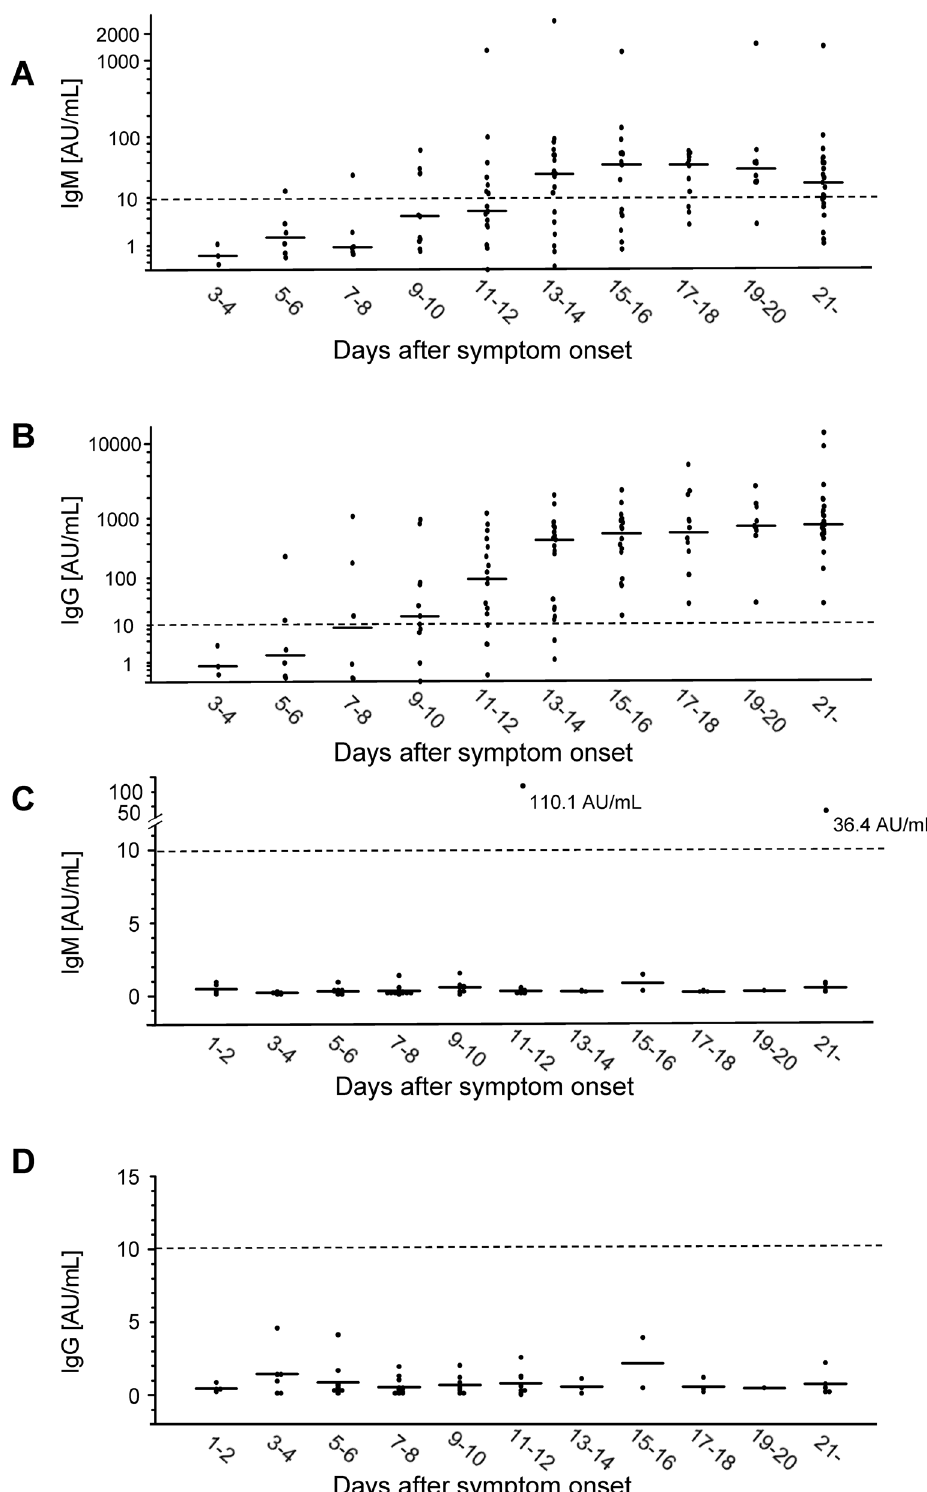
Figure 1. The time courses of serum titers of SARS-CoV-2 antibodies in COVID-19 patients after symptom onset. We measured the titers of SARS-CoV-2 IgM and SARS-CoV-2 IgG in 125 sera collected from RT-PCR- positive patients (n = 26) and 68 sera collected from RT-PCR-negative patients (n = 35). The data are plotted for days 1–2, 3–4, 5–6, 7–8, 9–10, 11–12, 13–14, 15–16, 17–18, 19–20, and ≥ 21 since symptom onset. The bars show the median titers at each timepoint. The broken line shows the manufacturer’s cutoff value (10 AU/mL). ( A ) RT-PCR-positive patients, IgM. ( B ) RT-PCR-positive patients, IgG. ( C ) RT-PCR-negative patients, IgM. ( D ) RT-PCR-negative patients,